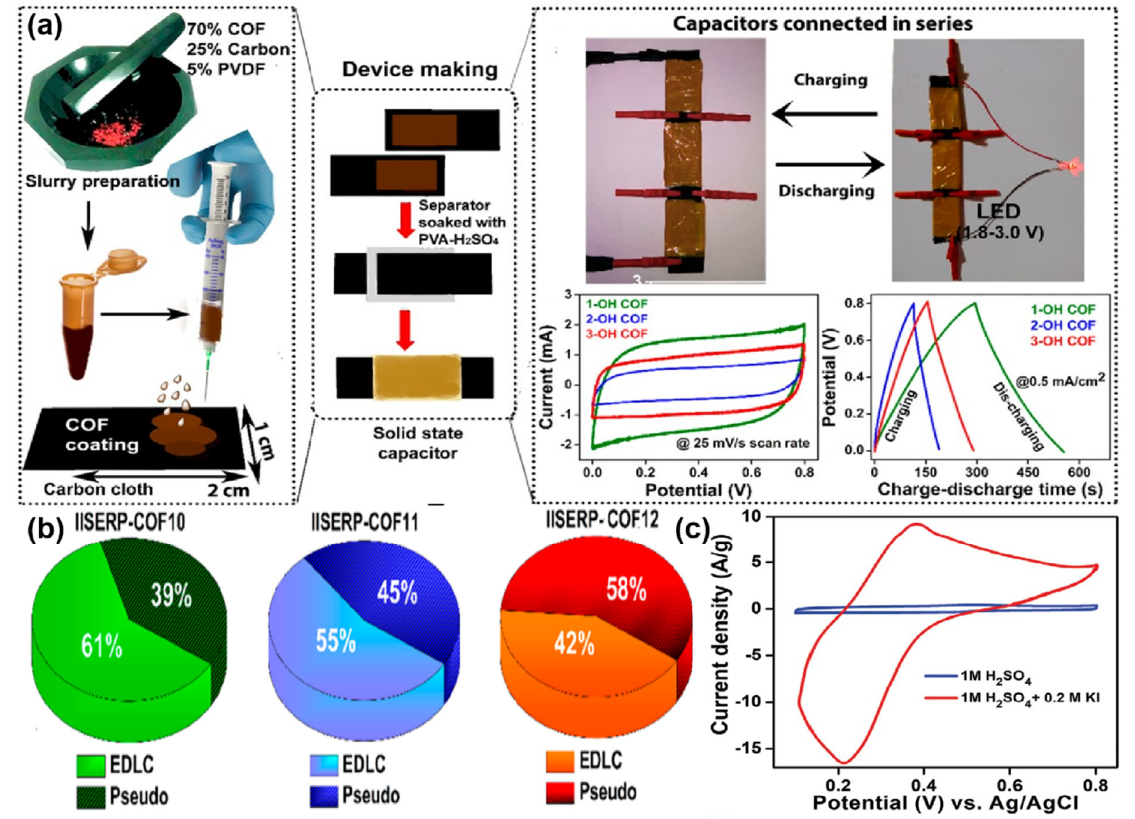
Figure 6. ( a ) The process of solid-state device preparation, CVs measured under solid-state conditions for the IISERP–COF10, IISERP–COF11, IISERP–COF12 and galvanostatic charge–discharge curves; ( b ) Graphical representation of capacitance contribution comes from EDLC and pseudo–activity of pyridine-rich COFs. Reprinted with permission from Ref. [68]. Copyright 2019, American Chemical Society. ( c ) Comparative CV plots of the COF–derived solid–state device (geometrical surface area = 1 cm 2 ) measured using 1 m H 2 SO 4 and 1 m H 2 SO 4 + 0.2 mKI as electrolyte @500 mV s –1 scan rate with a 10 mg total loading. Reprinted with permission from Ref. [70]. Copyright 2021,